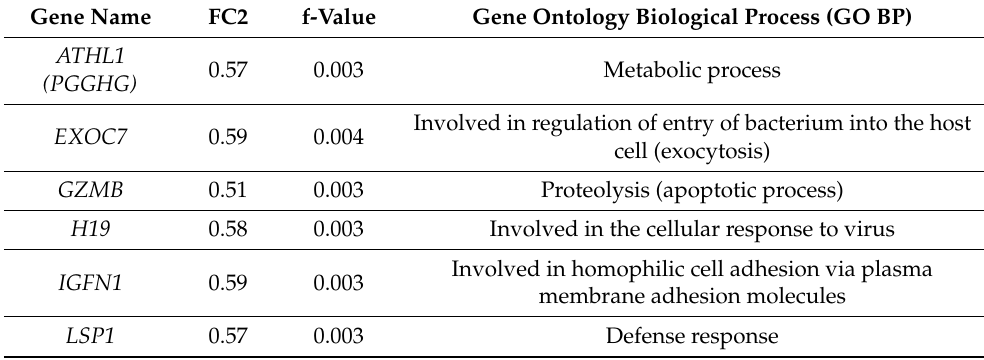
Table 2. The most downregulated transcripts in Saos-2 cells exposed on the rough surfaces of Y-TZP discs for 96 h (f-value ≤